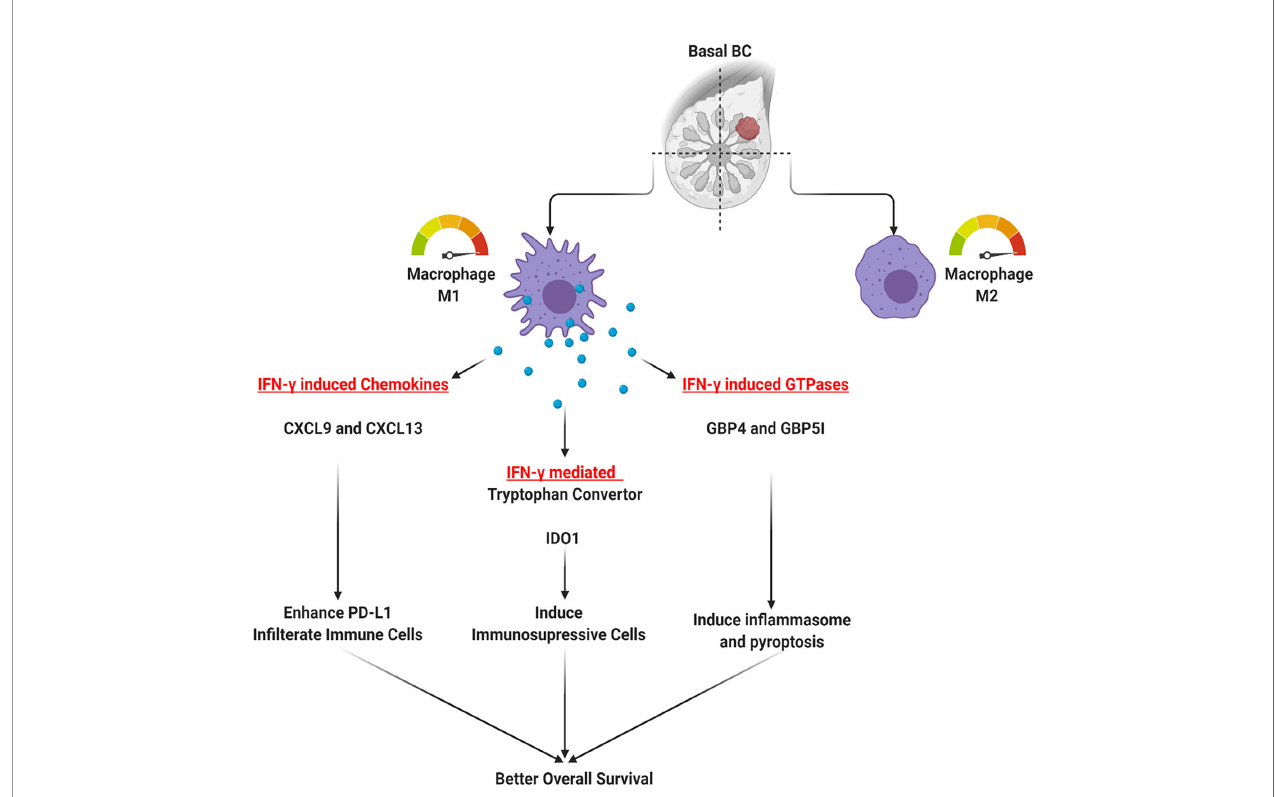
FIGURE 8 | Possible mechanisms through which M1 might mediate the favorable outcome in basal-like triple-negative breast cancer (TNBC)